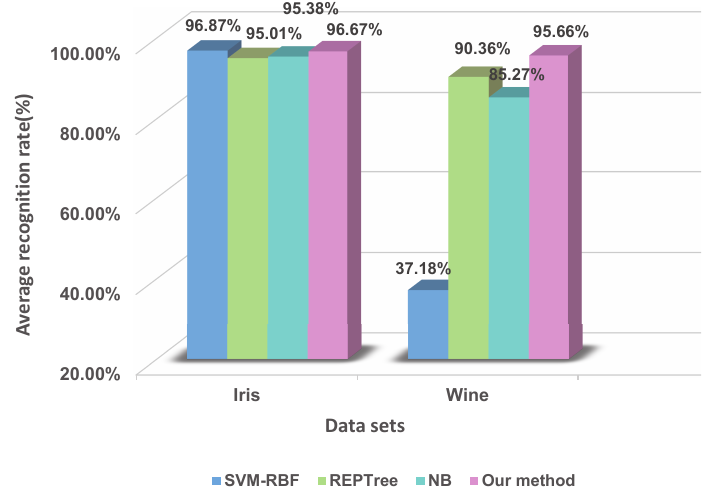
Figure 7. The comparing results between our method and other